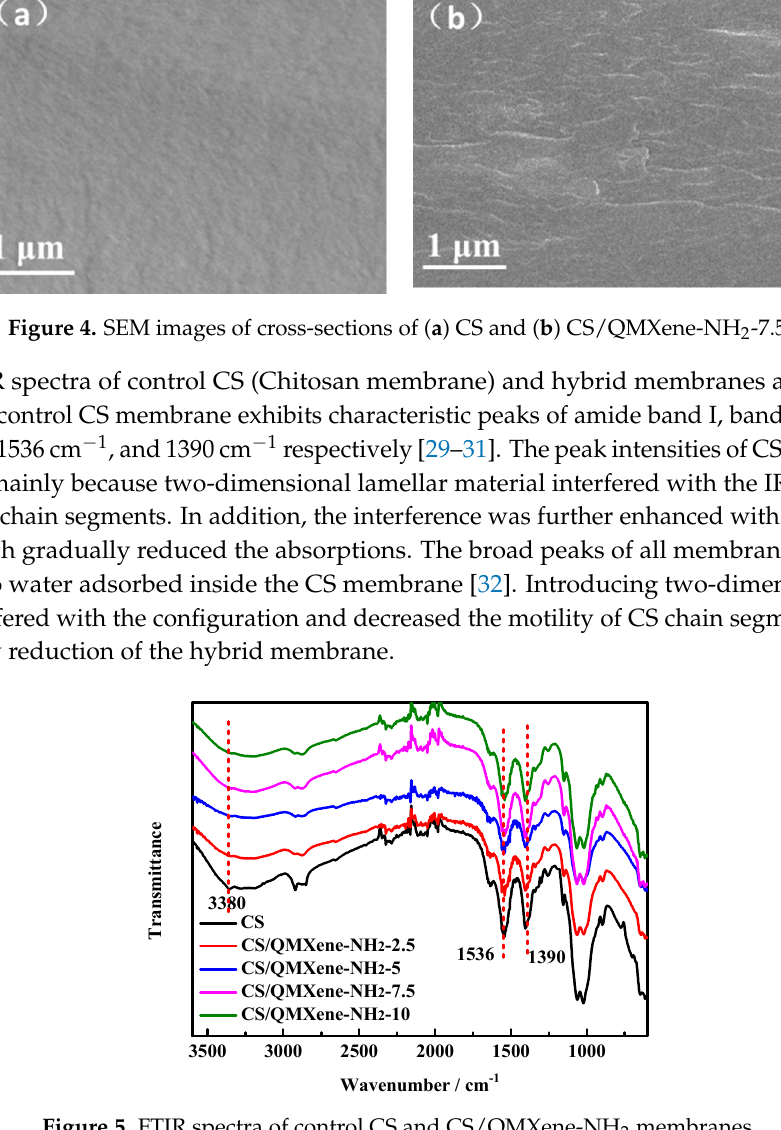
Figure 5. FTIR spectra of control CS and CS/QMXene-NH 2 membranes.